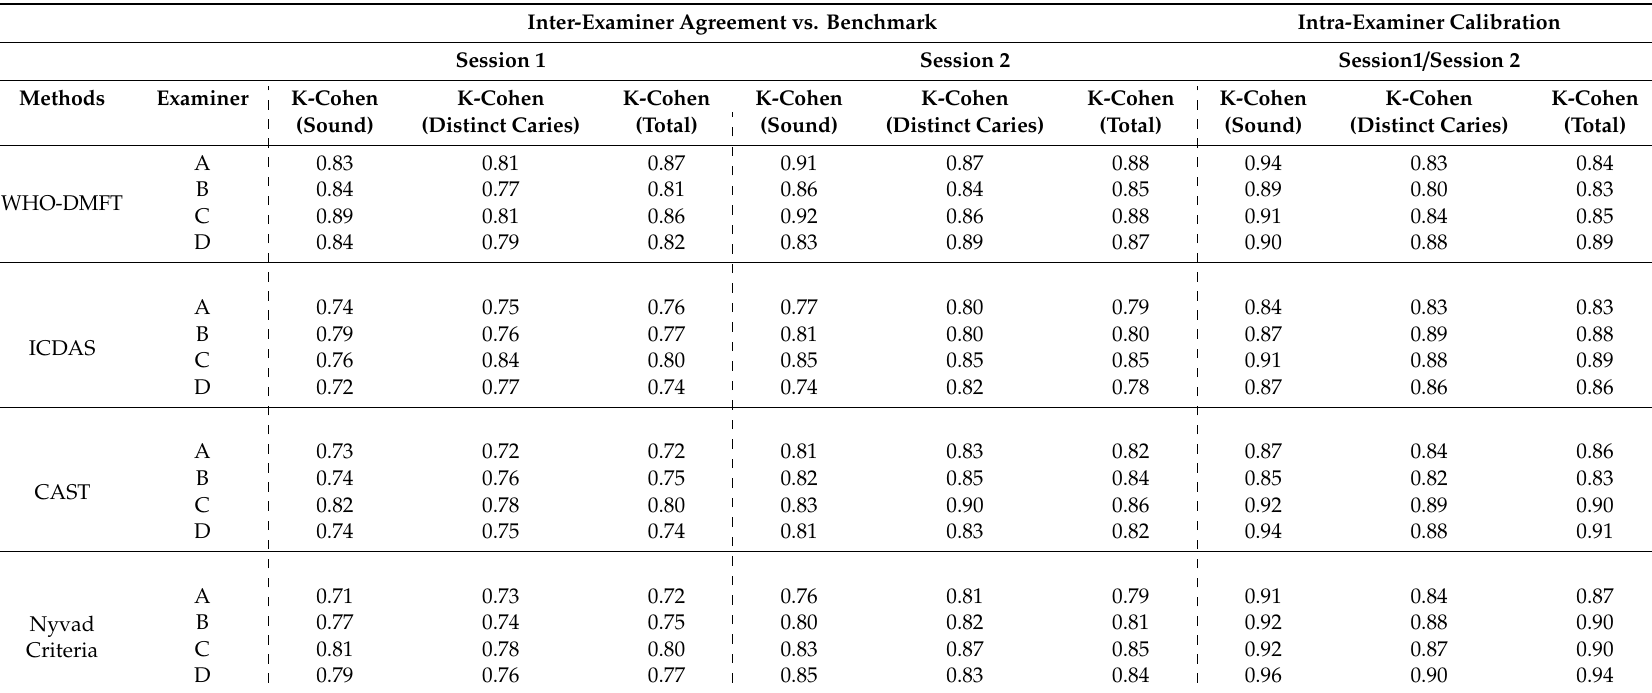
Table 3. Calibration agreement (criterion K = 0.75) of the four examiners (A–D) vs. the benchmark for the di ff erent caries detection methods and intra-examiner agreement (criterion K = 0.80). The K-Cohen value was calculated at the sound level and at the distinct caries level; moreover, a total value was